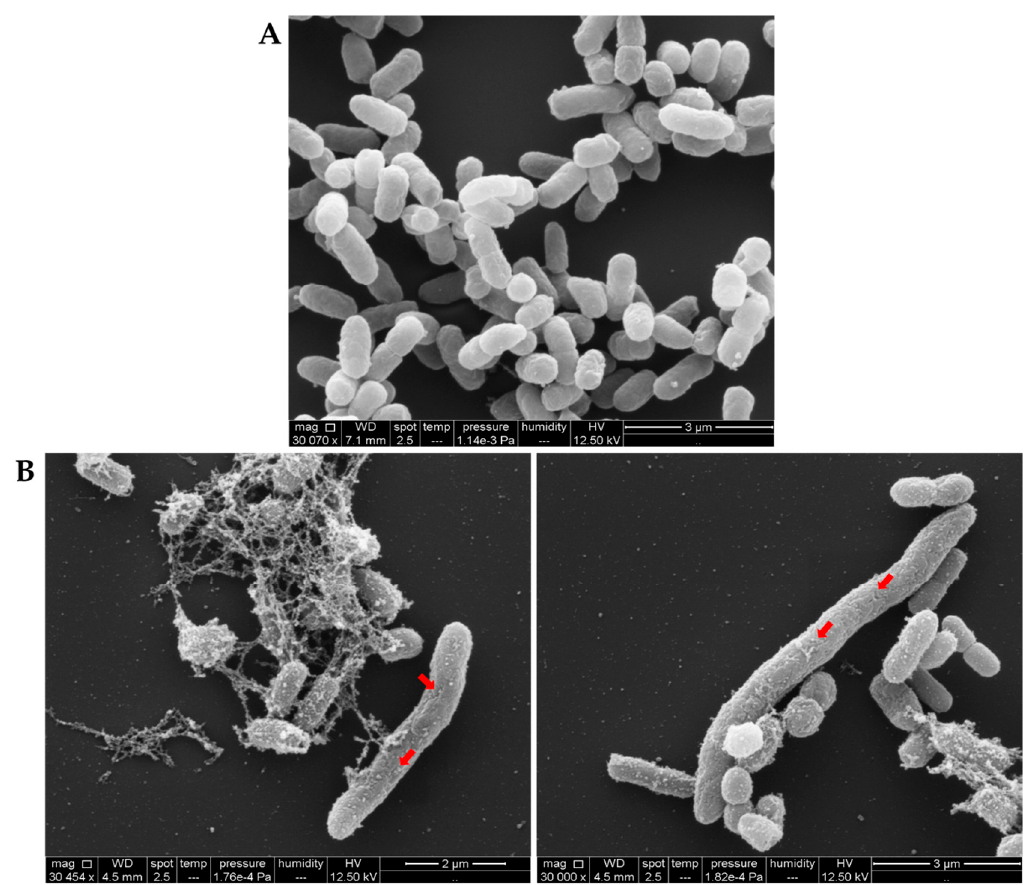
Figure 10. Sarconesin II MIC effect on E. coli bacterial membrane by scanning electron microscopy (SEM). Untreated E. coli ( A ) had a normal smooth surface, while treatment with sarconesin II ( B ) gave an elongated pattern, membrane disruption and blebbing on the outer face (arrows). Some bacteria had variable length, rough cell surfaces or globular protrusions on their surfaces. These images revealed that sarconesin II could induce alterations in cell morphology.